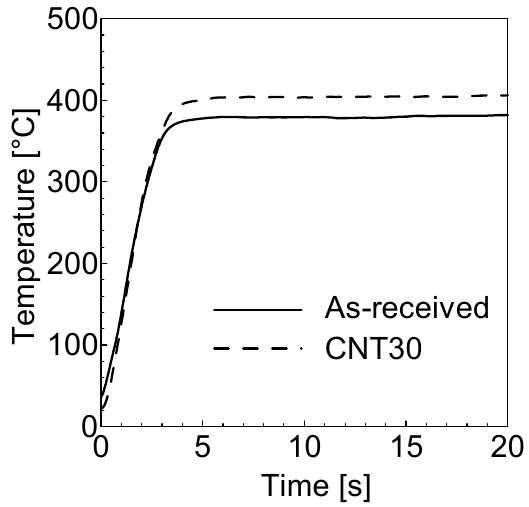
Figure 10. Temperature history of As ‐ received and CNT30 when applying the output power.